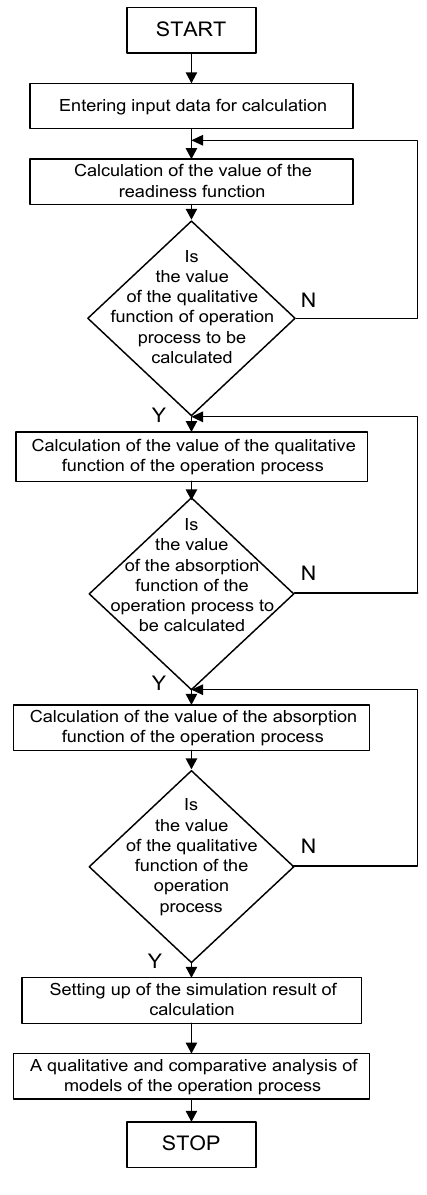
Figure 2. Algorithm of simulation studies on the quality of the evaluation of the exploitation process of a technical object.